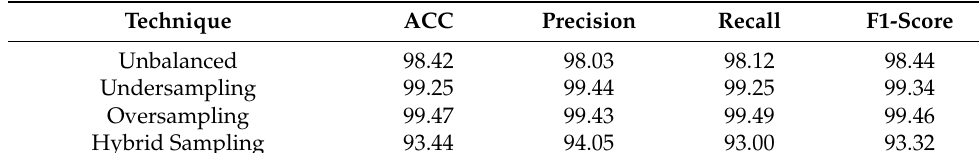
Table 16. Overall results for the CICIDS2017 Dataset.